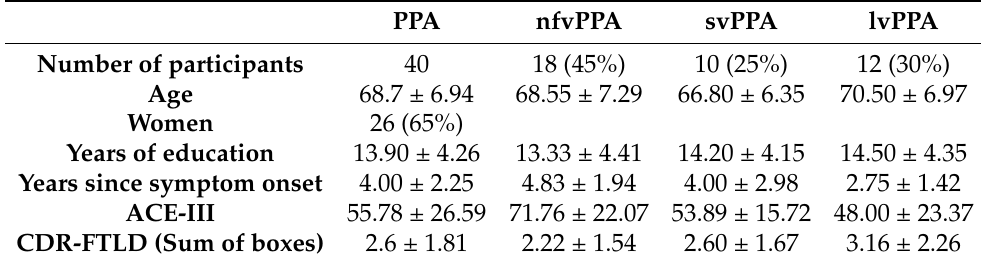
Table 1. Main clinical and demographic